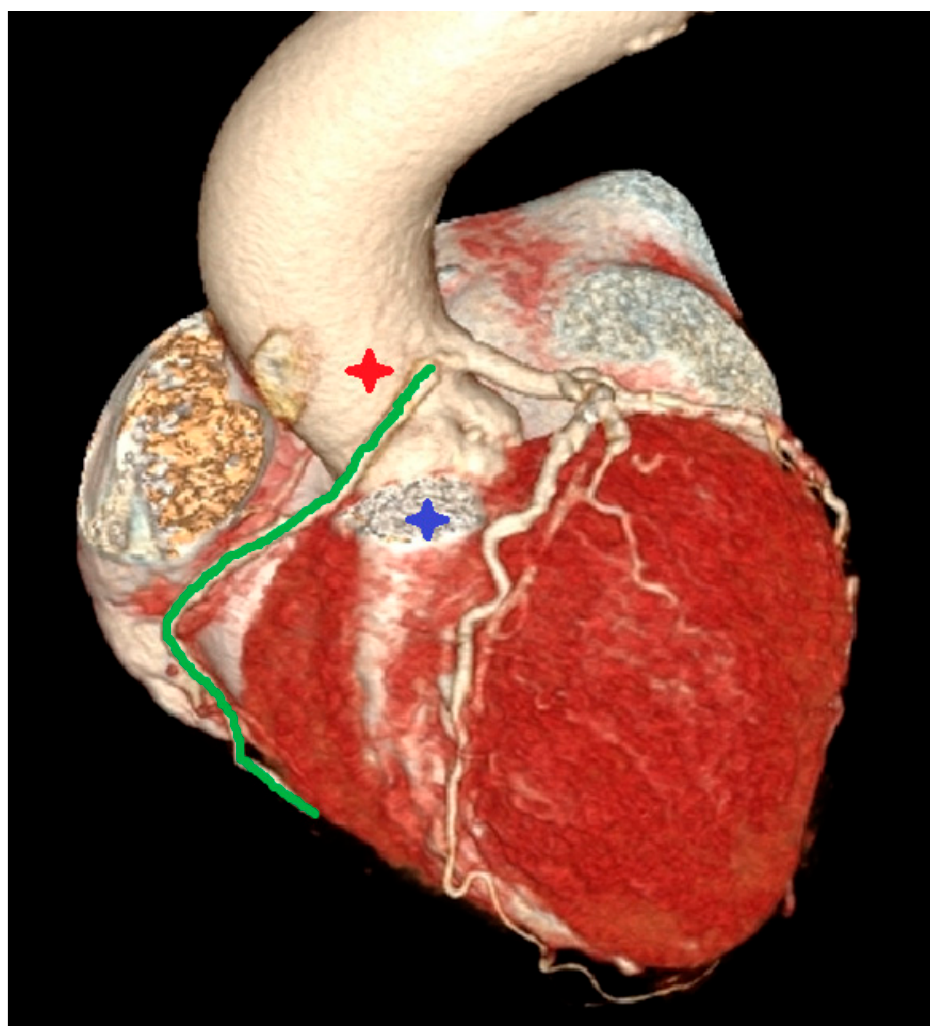
Figure 6. Interarterial course of the right coronary artery.